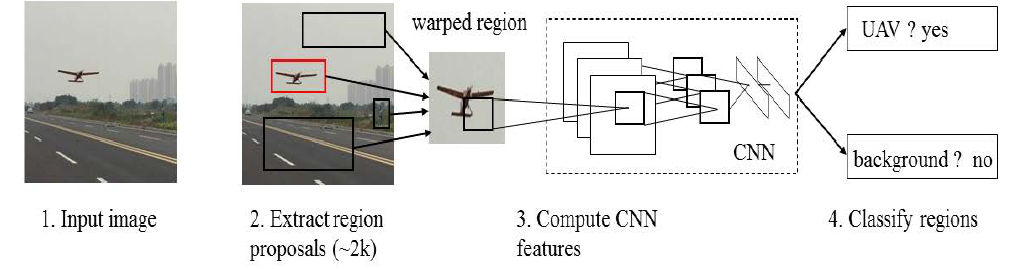
Figure 6. Region-Convolutional Neural Network (R-CNN) system